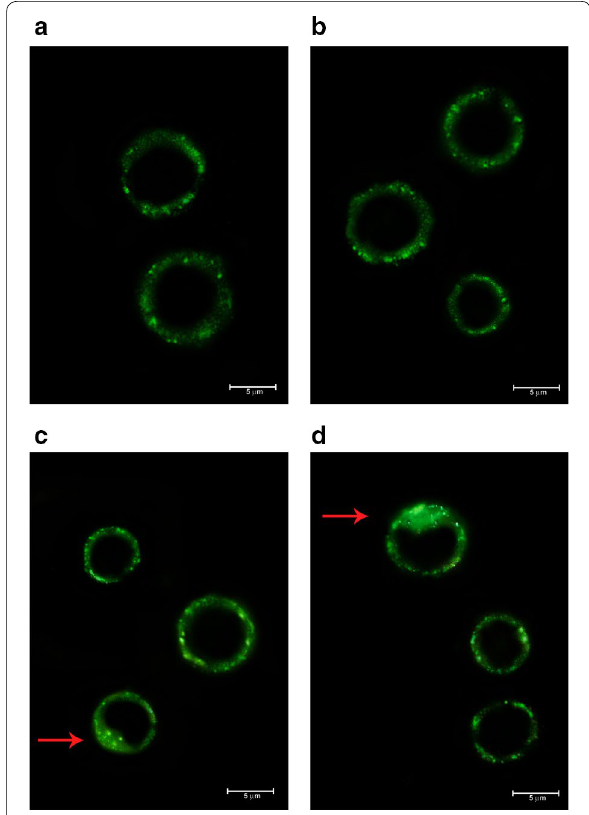
Fig. 6 Immunofluorescence staining of Raji cells for confirmation of binding activity and internalization of scFv–apoptin. Raji cells were incubated with scFv–apoptin at 4 °C (5 µg/mL) ( a ), RFB4 at 4 °C (500 ng/mL) ( b ), scFv–apoptin at 37 °C ( c ), and RFB4 at 37 °C ( d ). After 2 h of incubation, cells were washed, fixed, permeabilized and treated with anti-6XHis-tag antibody and FITC anti-mouse IgG. Observation under the fluorescence microscope revealed cell surface binding and internalization (indicated by arrows ) of the fusion